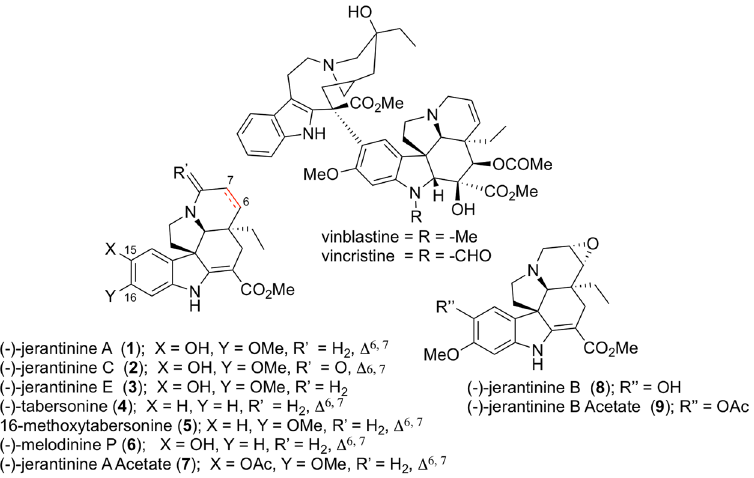
Figure 1. A selection of Vinca and Aspidosperma